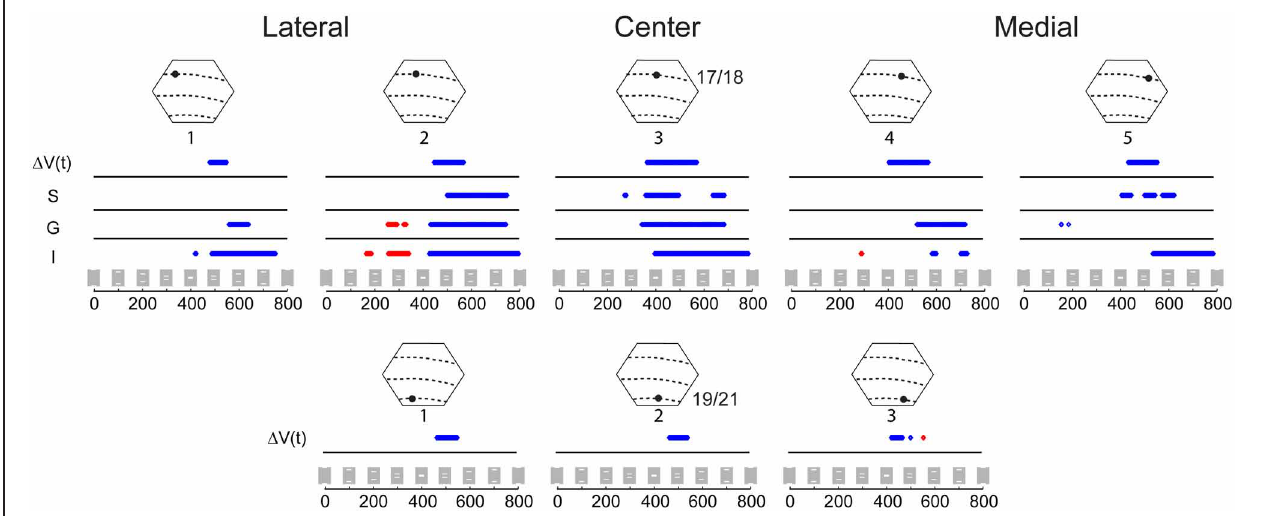
FIGURE 4 | Statistical comparison of the amplitude of the variables (cid:2) V ( t ) and MUA for the occlusion condition compared to the amplitude of the sum of (cid:2) V ( t ) and sum of MUA from the single bar conditions. The MUA was recorded from supragranular (S), granular (G), and infragranular (I) cortical layers at five sites along the 17/18 border (Top) and for the (cid:3) V ( t ) at three sites along the 19/21 border, (Bottom) (Sites identical to those in